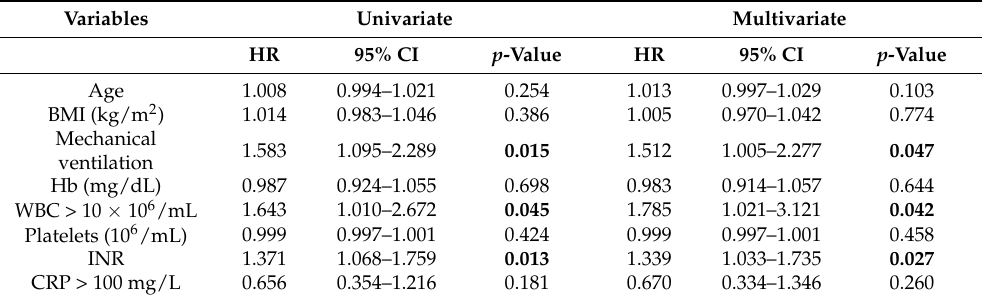
BMI, body mass index; CRP, C-reactive protein; Hb, hemoglobin; INR, international normalized ratio; WBC, white blood cell count. Level of significance p < 0.05. Bold type indicates statistical sig- nificance. Table 6. Uni- and multivariate Cox regression analyses on day 3 within the entire study cohort with regard to 30-day all-cause mortality. Variables